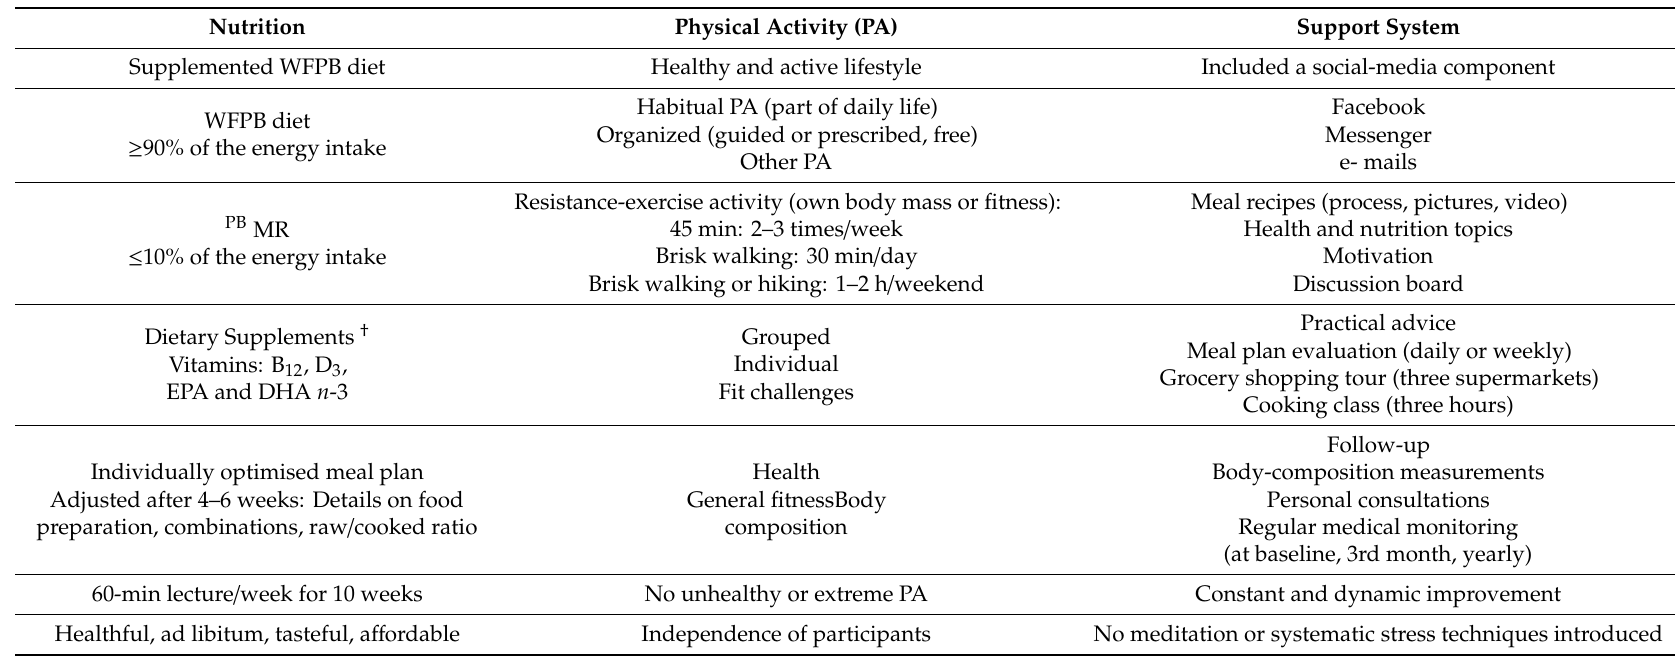
Table 1. A whole-food plant-based (WFPB) lifestyle